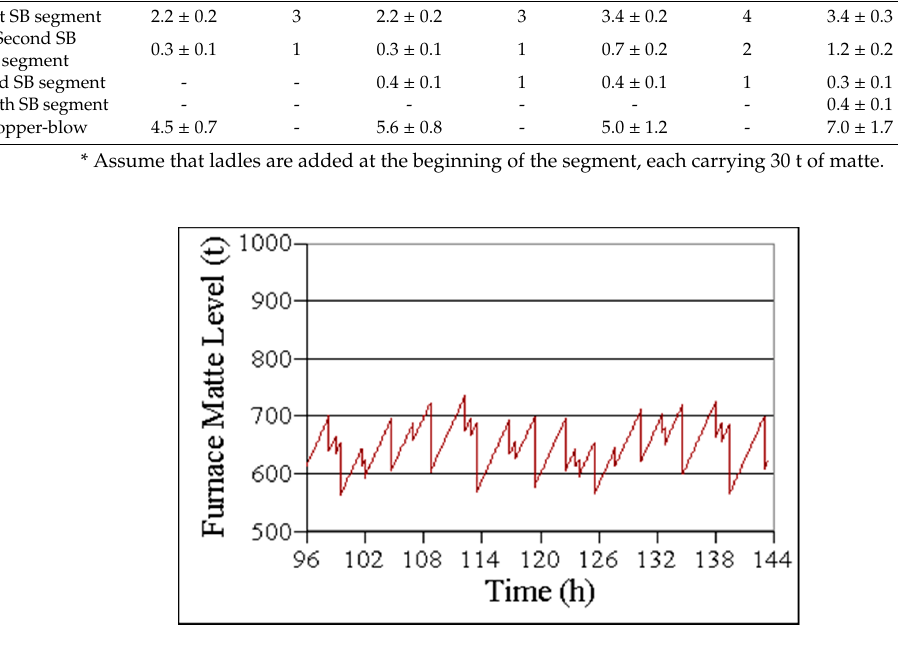
Table 4. Example of PS converting data, including short and long cycles that can be extended. Regular Short C. Extended Short C.